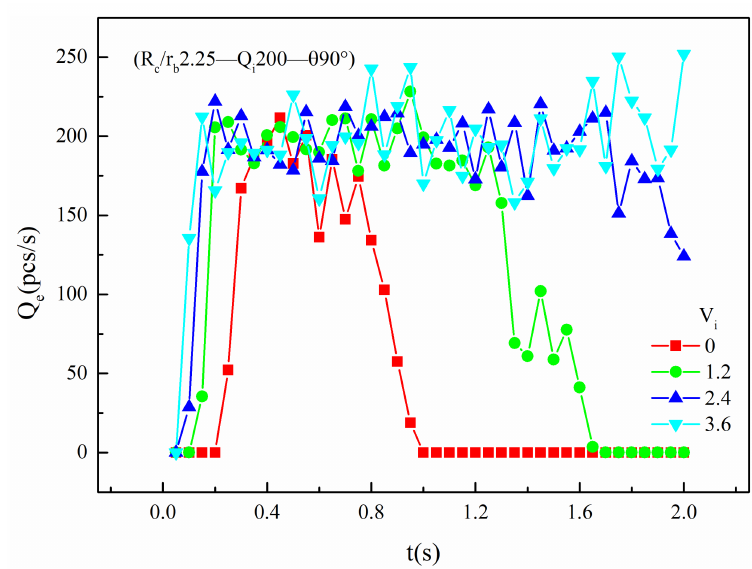
Figure 13. The Qe versus time with different V i